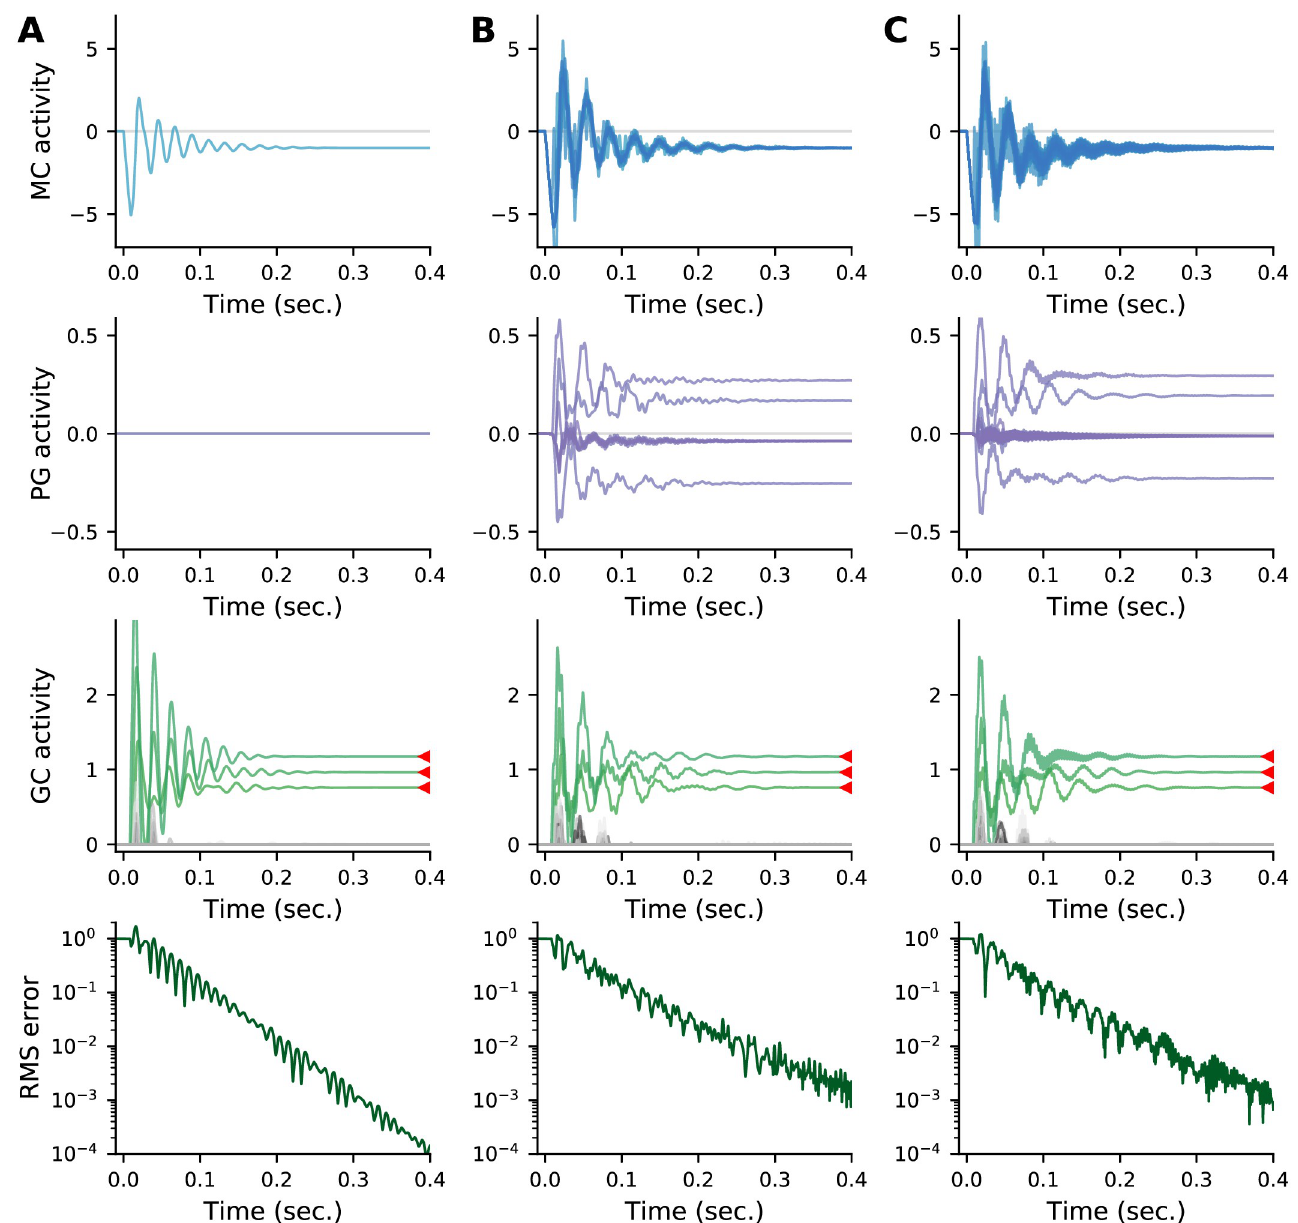
Fig 6. Typical dynamics as the number of mitral cells per glomerulus, S , is varied relative to the base model given in Table 1. (A) S = 1, (B) S = 8, and (C) S = 25 mitral cells per glomerulus, compared to S = 4 in Fig 5. Note the lack of periglomerular cell activity and slightly faster convergence for S = 1. Otherwise, the dynamics is qualitatively similar for all values of S , including convergence to the MAP